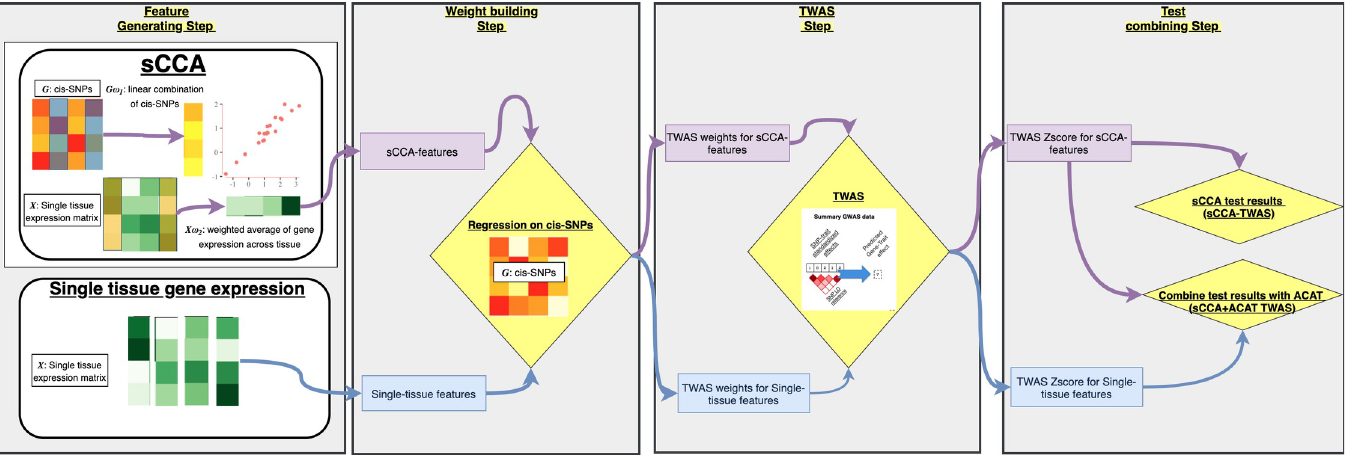
Fig 1. Methods overview. The single-tissue-based cross-tissue TWAS approach is shown in blue arrows, the PCA based cross-tissue TWAS approach is shown in red arrows, and the sCCA-TWAS approach is shown in purple arrows.